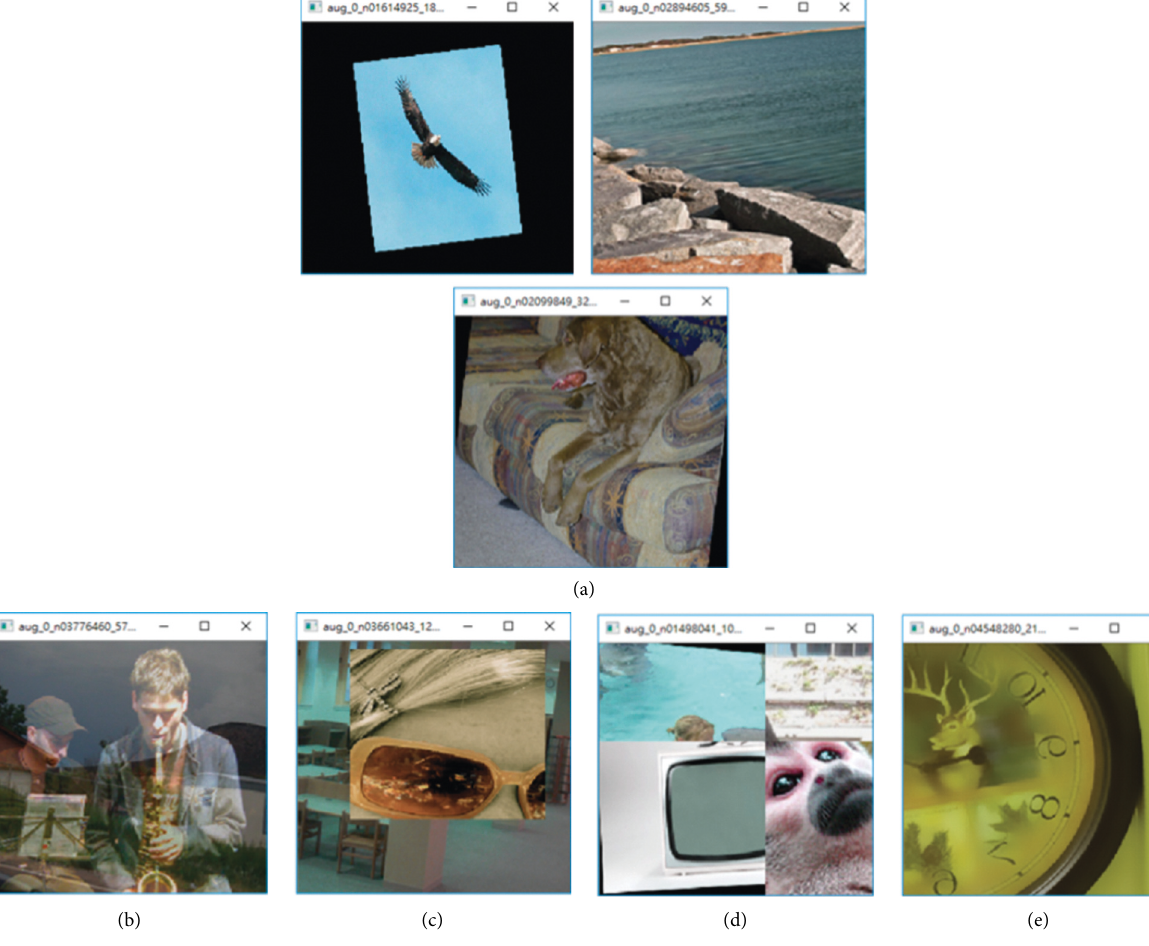
Figure 10: Data augmentation techniques